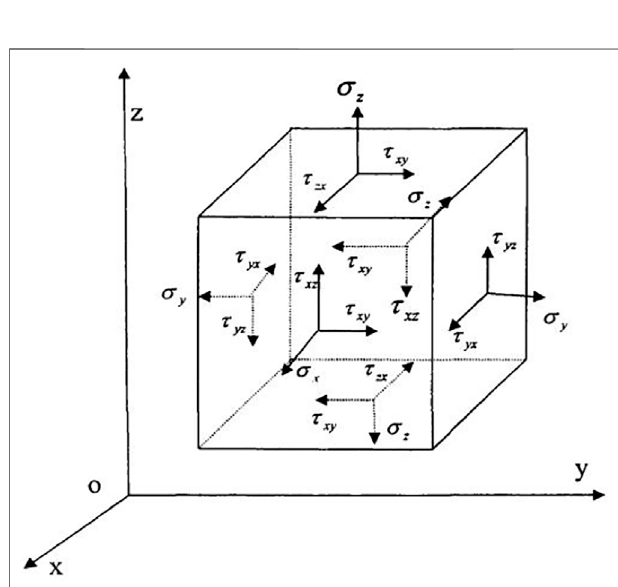
FIGURE 5 | Schematic diagram of forces acting on a rock element (Dai., 2006). Notes: σ x , σ y , σ z are normal stresses in x , y , and z directions; τ xy and τ yx are shear stresses on x and y planes; τ xz , τ zx are shear stresses on x and z planes; τ yz and τ zy are shear stresses on y and z